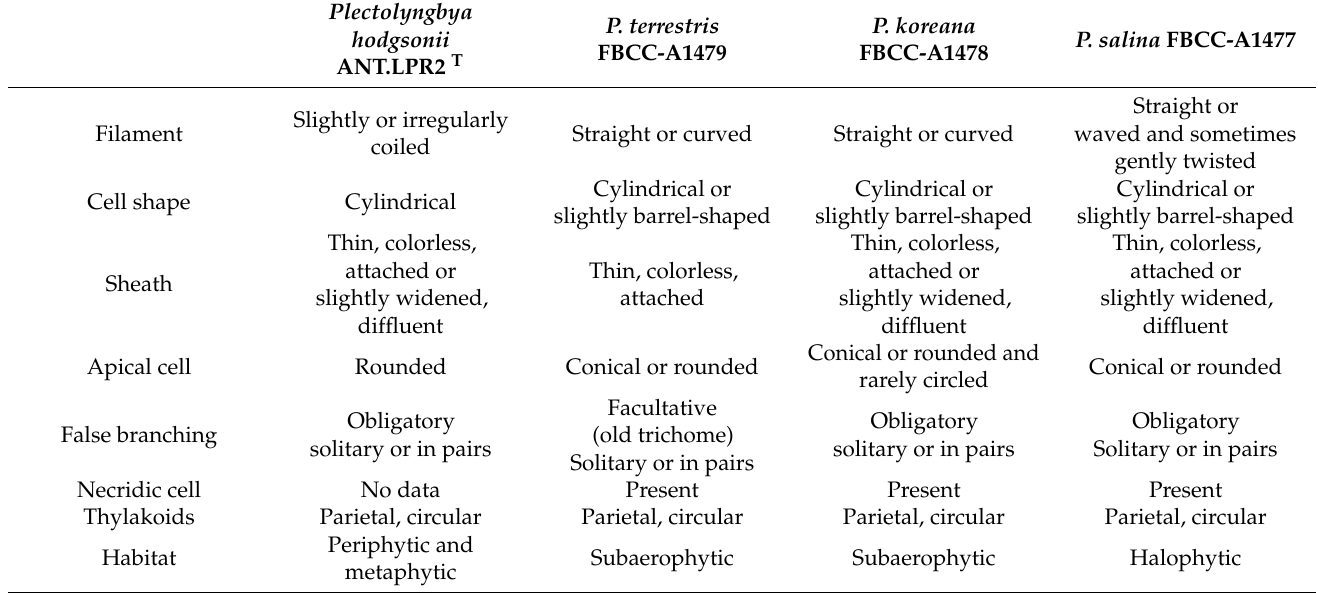
Table 2. The comparison of the morphological characters of Plectolyngbya